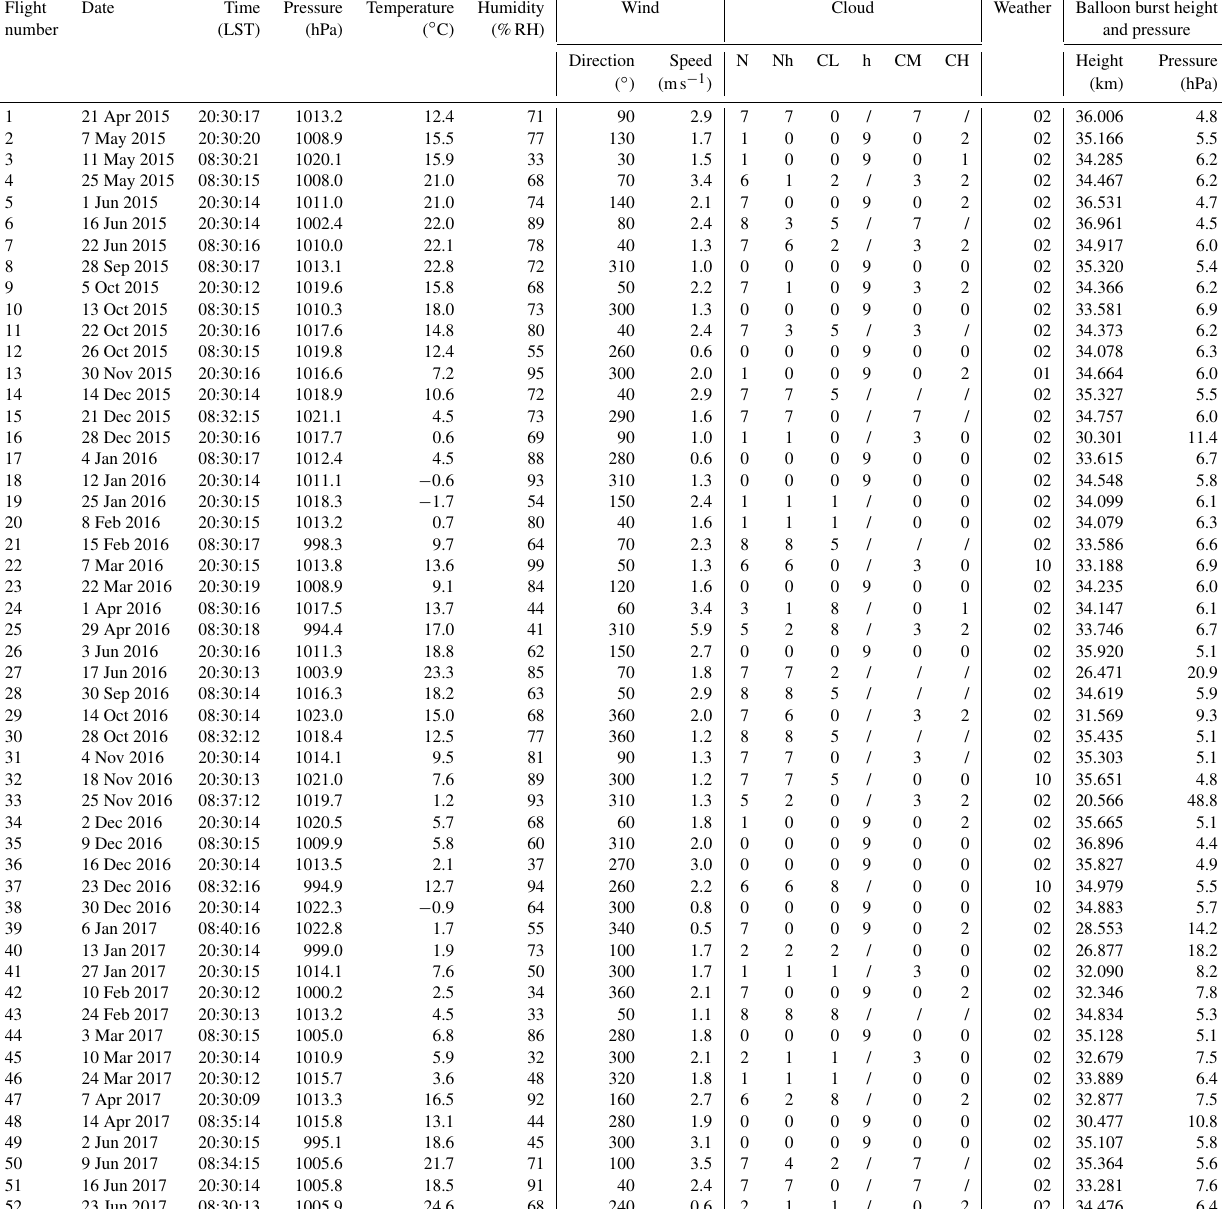
Table 2. Flight information including surface observation, cloud cover data, and balloon burst height from RS-11G data. CL, CM, and CH denote types of low, medium, and high cloud. The N denotes total cloud cover, Nh the fraction covered by all CL cloud, and h the coded height of the lowest cloud